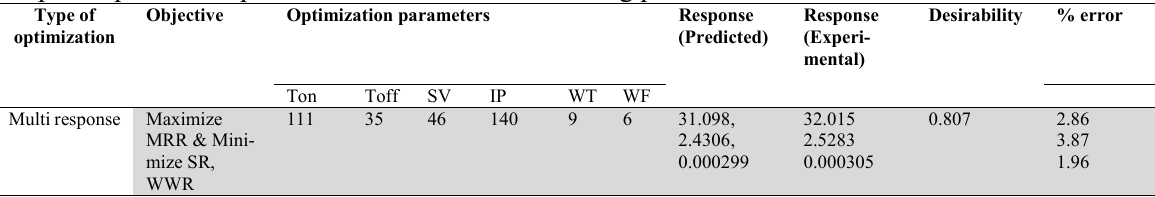
Output responses at optimum combination of machining parameters Type of